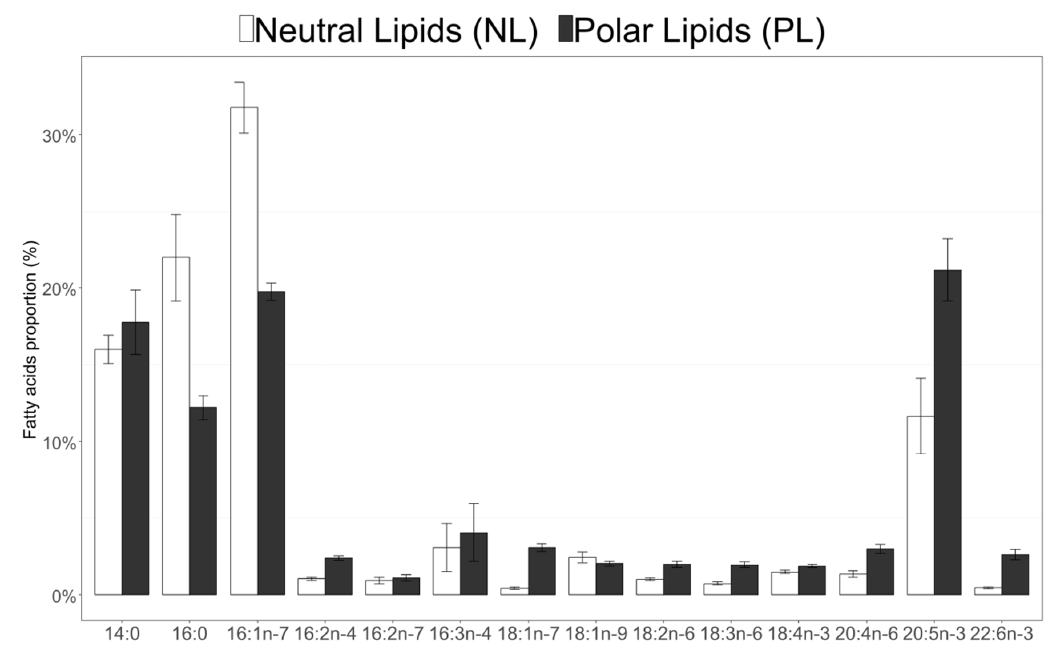
Figure 6. Proportions (% of Total Fatty Acids) of main fatty acids in neutral lipids (NL) and polar lipids (PL) of C. muelleri . (Mean ± SD n = 16 for each fraction). Among the 44 identified fatty acids (FA), only those accounting for more than 1% of the TFA are represented here (between 0.1% and 1%,